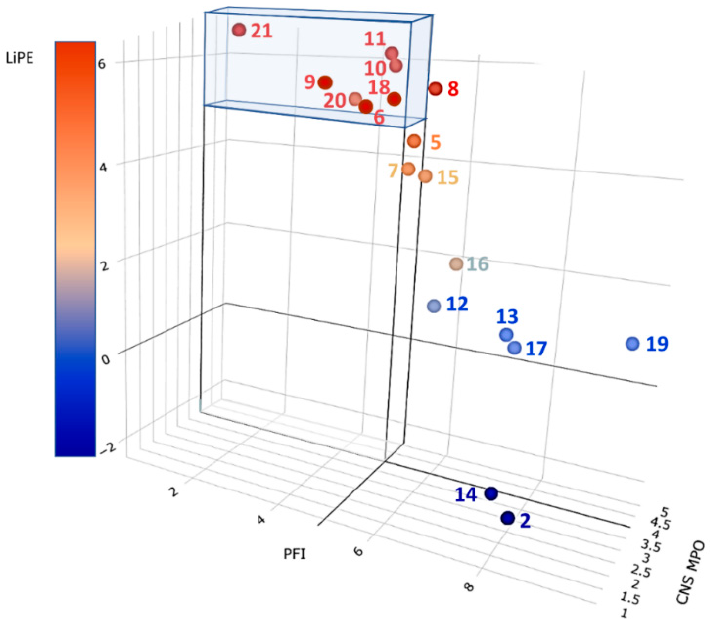
Figure 7. Ligand efficiency metric analysis on the selected inhibitors 2 , 5–21 . Compounds falling within the colored volume are expected to display the highest efficiency, selectivity, and brain permeation. See text and Table S1 for details.